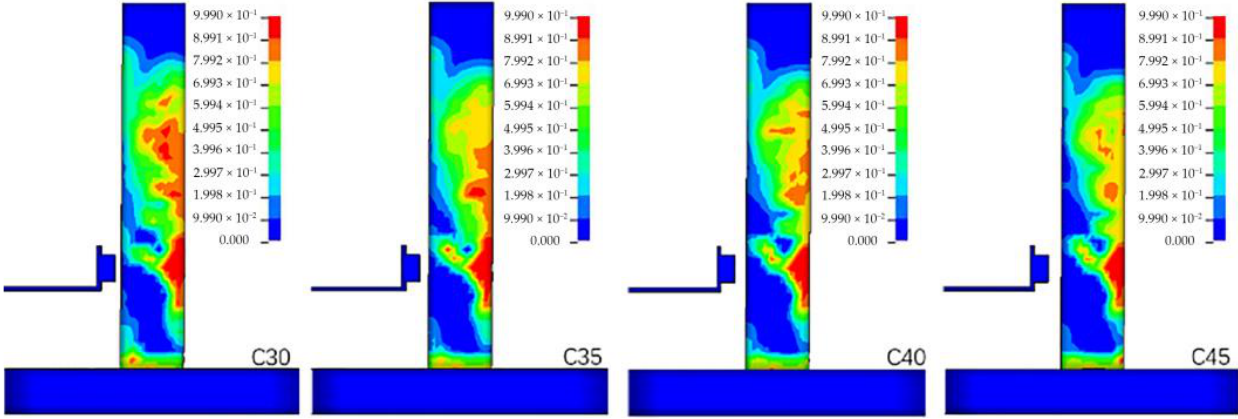
Figure 22. Influence of concrete strength grade on impact damage of model column.